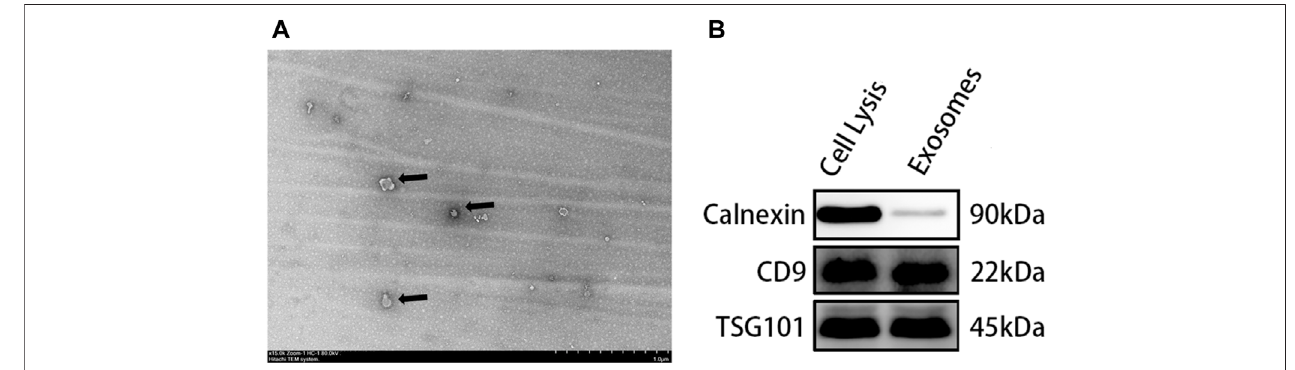
FIGURE 2 | Identi fi cation of Exos: (A) The size and morphology of exosomes observed using TEM; (B) Speci fi c markers of exosomes detected by Western